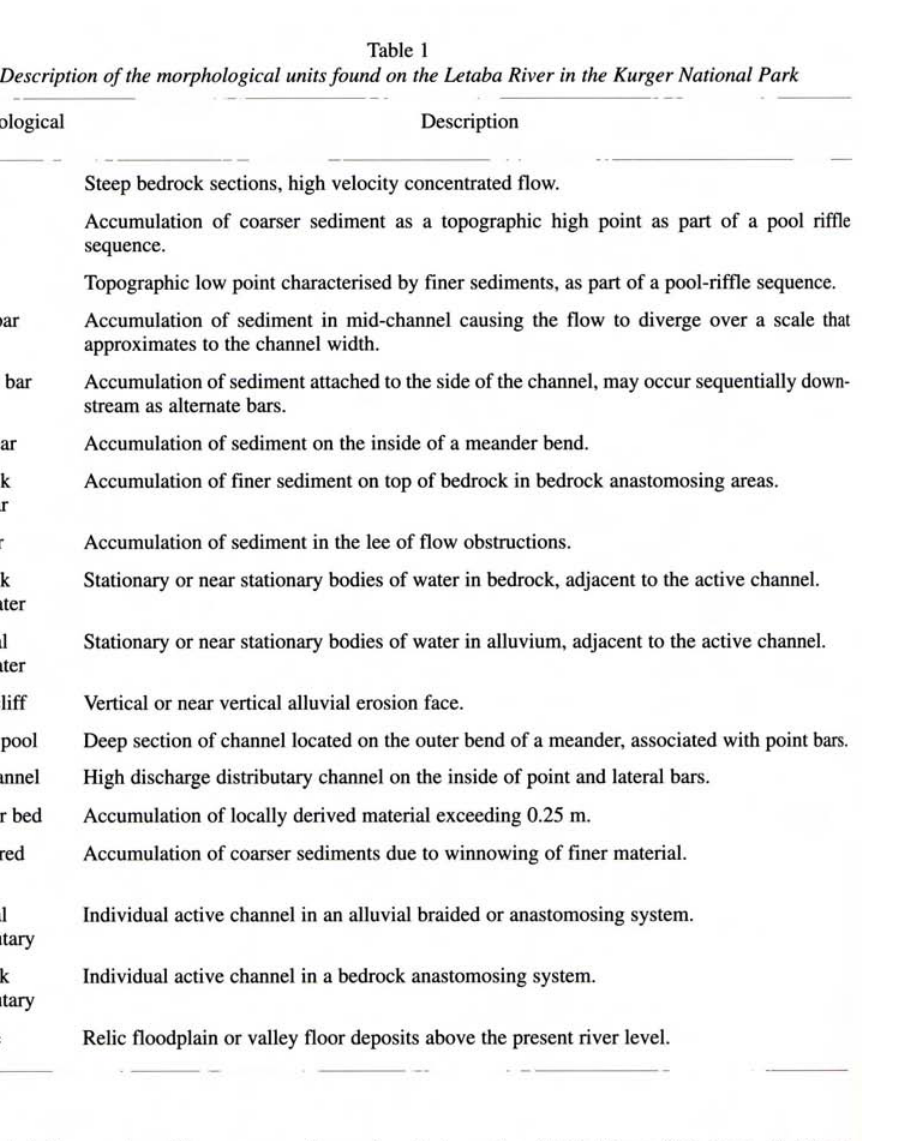
Table I Description of the morphological units found on the utaN River in the Kurger National